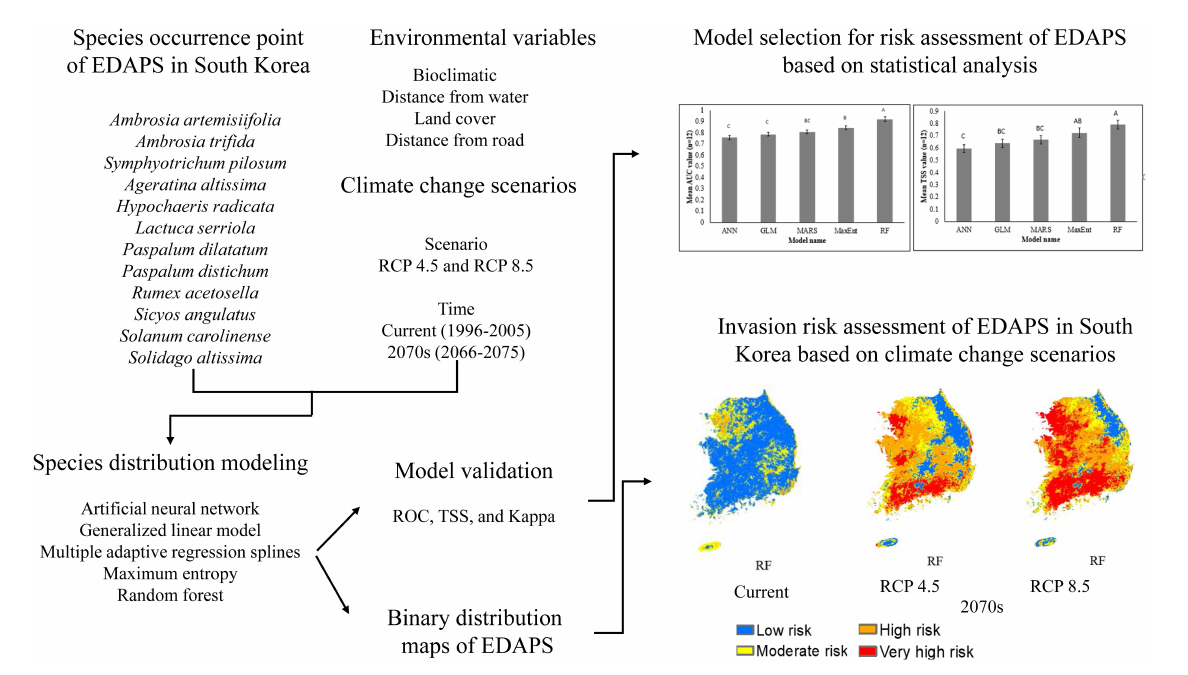
FIGURE2 Flow chart showing database and modeling methods for predicting EDAPS invasion risk in South Korea.